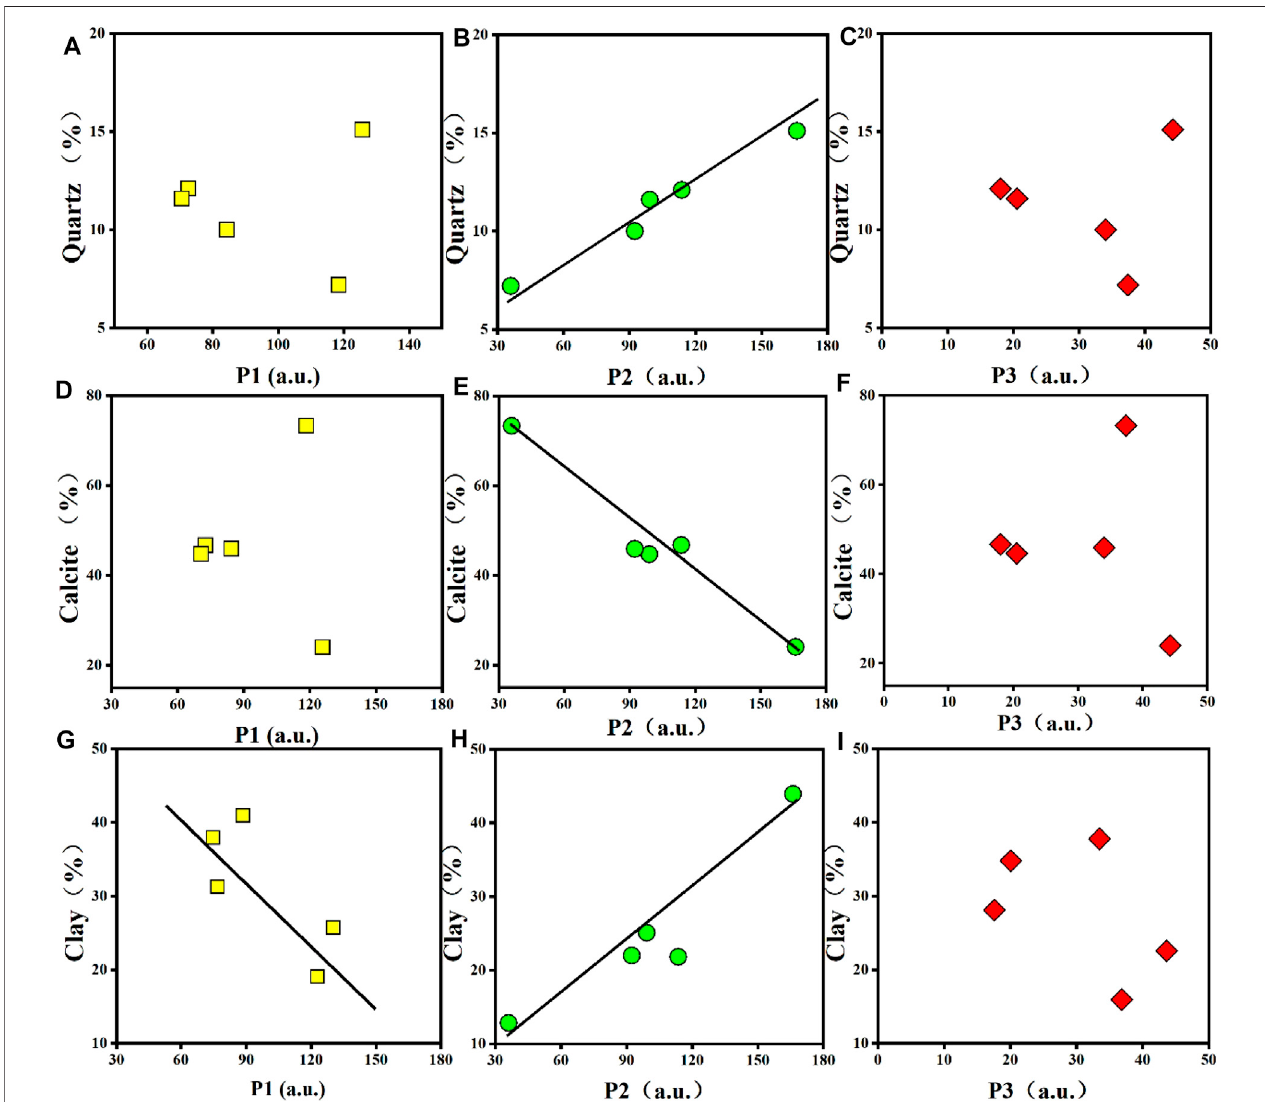
FIGURE 14 | Relationship between mineral compositions and areas of three peaks for dodecane-saturated samples.